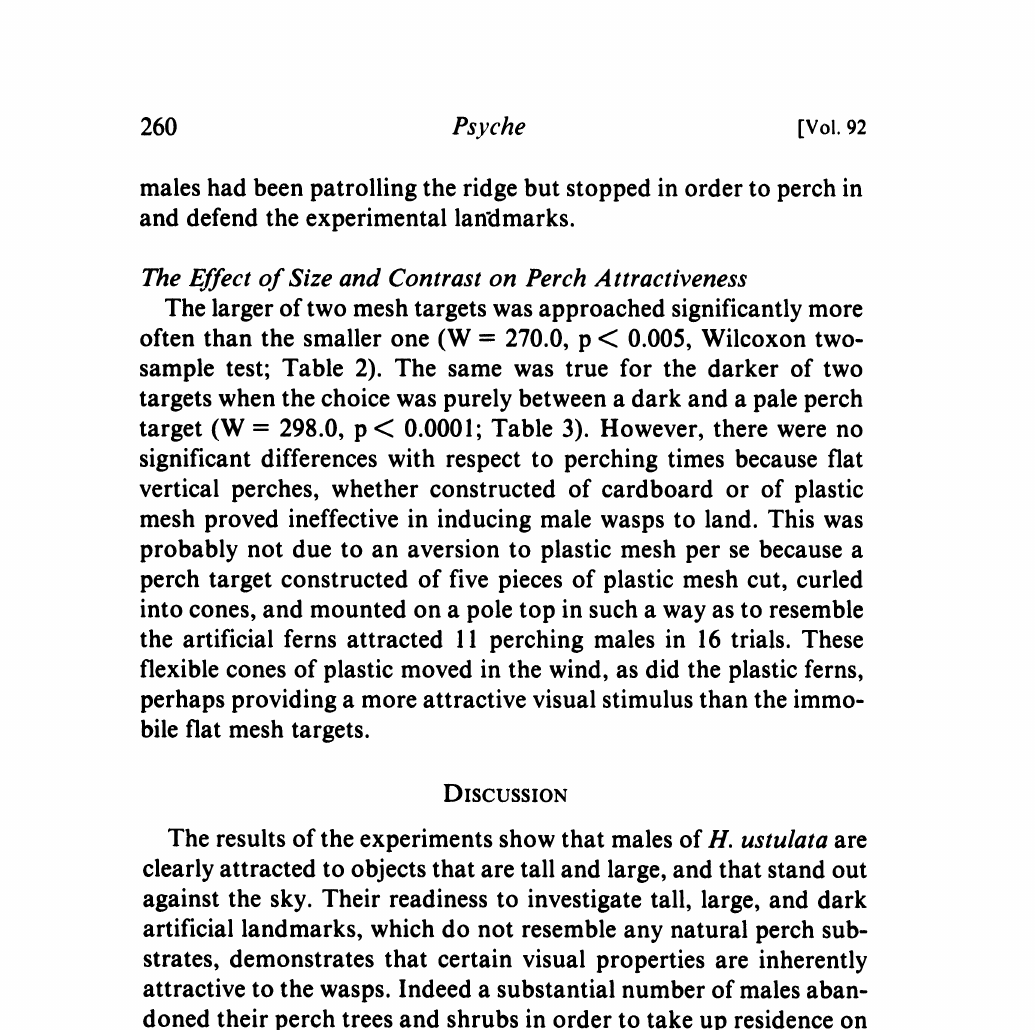
Table 2. The effect of size of artificial perches on the frequency with which male tarantula hawks approached and perched on them during 15-min trials. Number Number Perch Target of Paired Mean Mean of Males Material Size Trials Approaches Perching Time (rain) Perching